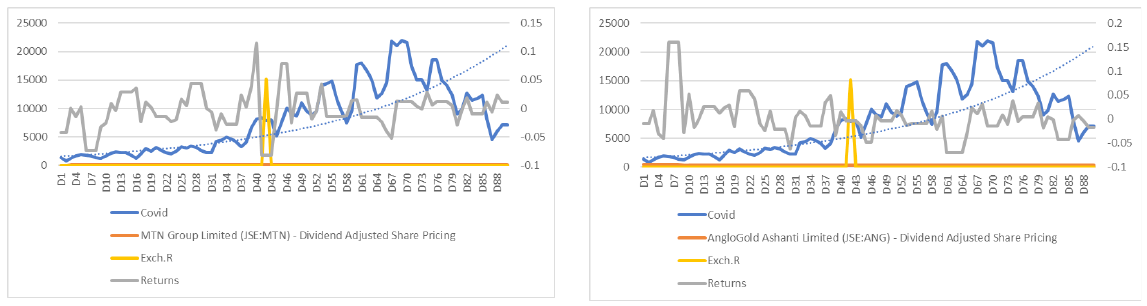
Figure 3. AngloGold Ashanty Limited